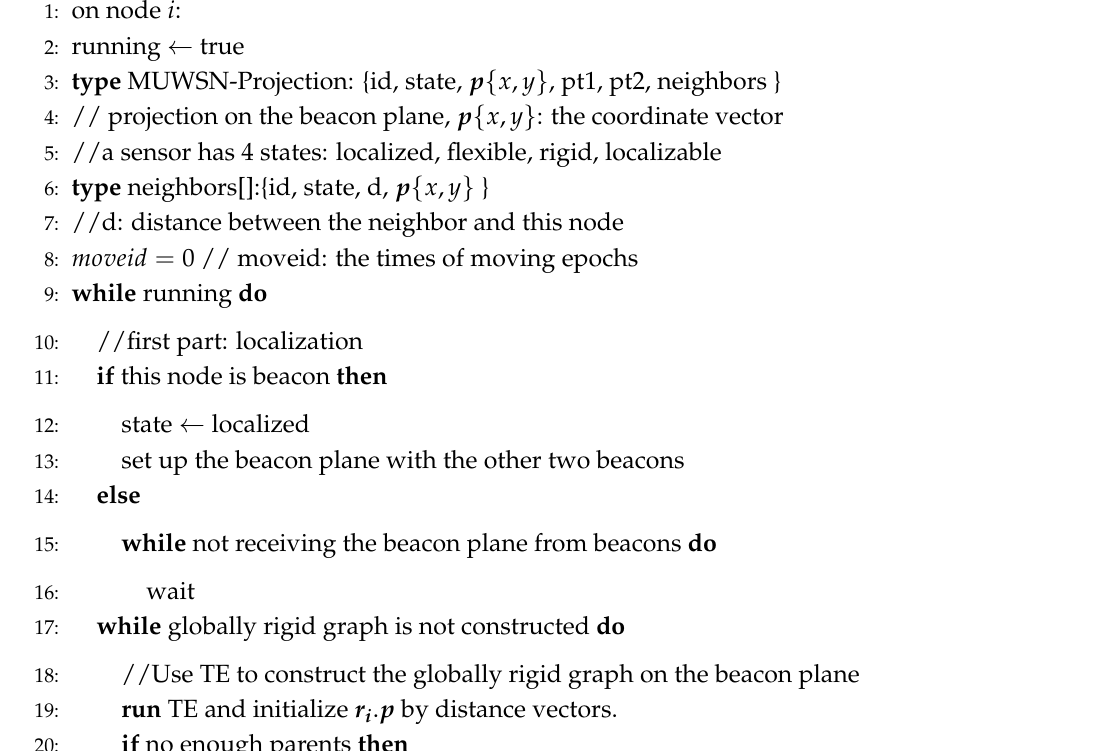
Algorithm 1 ProLoAlg distributed localization and control